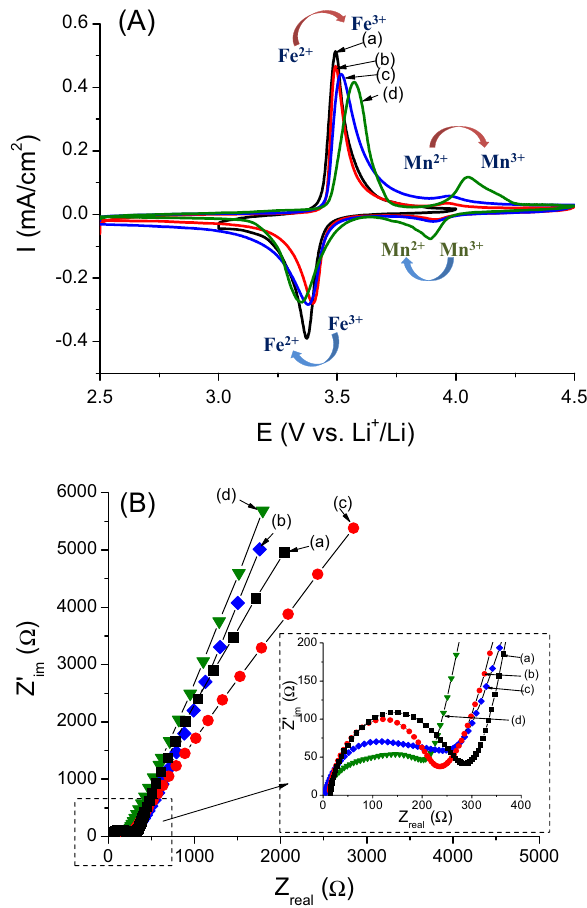
Figure 4. ( A ) Cyclic voltammograms at a scan rate of 5 mV s −1 and ( B ) corresponding Nyquist plots of electrochemical impedance spectroscopy (EIS) of synthesized olivine samples: (a) LiFePO 4 ; (b) LiMn 0.1 Fe 0.9 PO 4 ; (c)